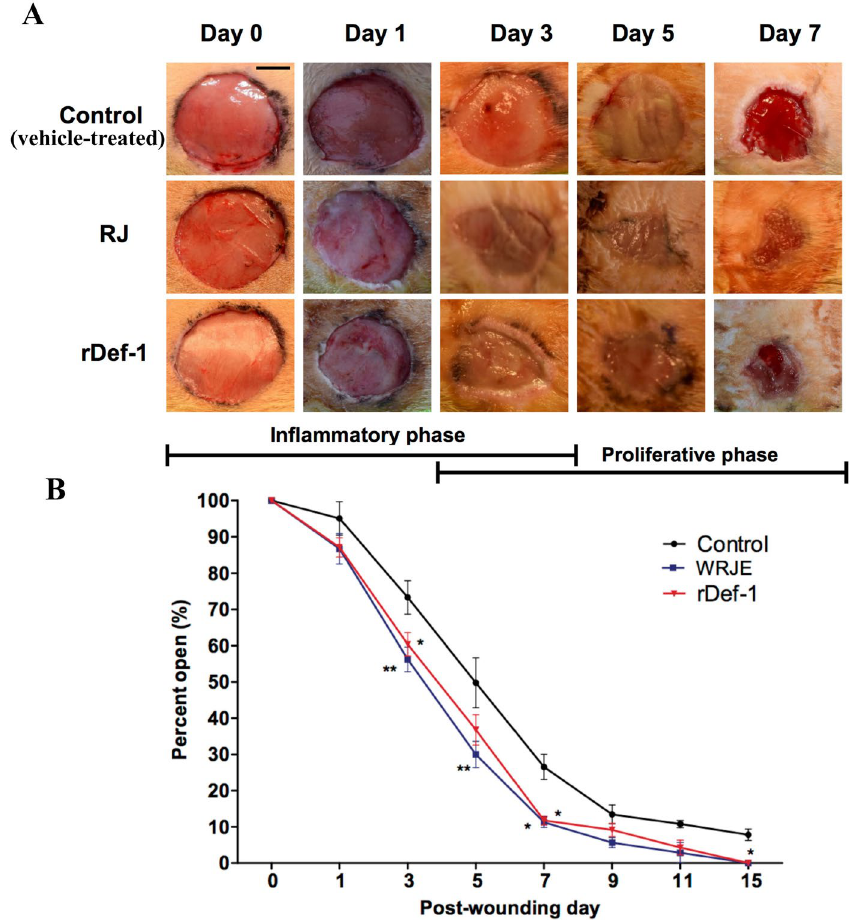
Figure 6. Typical macroscopic appearance of royal jelly (RJ) and recombinant defensin-1 (rDef-1) treated wounds compared with vehicle (carboxymethyl cellulose)-treated control wounds. RJ and rDef-1 treated wounds exhibited more rapid wound closure, especially at day 7 post-wounding ( A ). Wound healing curve ( B ) demonstrating significant differences between treated and control wounds. Data are expressed as means and SEMs of 4 to 20 independent measurements. Asterisks indicate a significant difference from the control (vehicle-treated) group, * P < 0.01, ** P < 0.05. Scale bar = 5